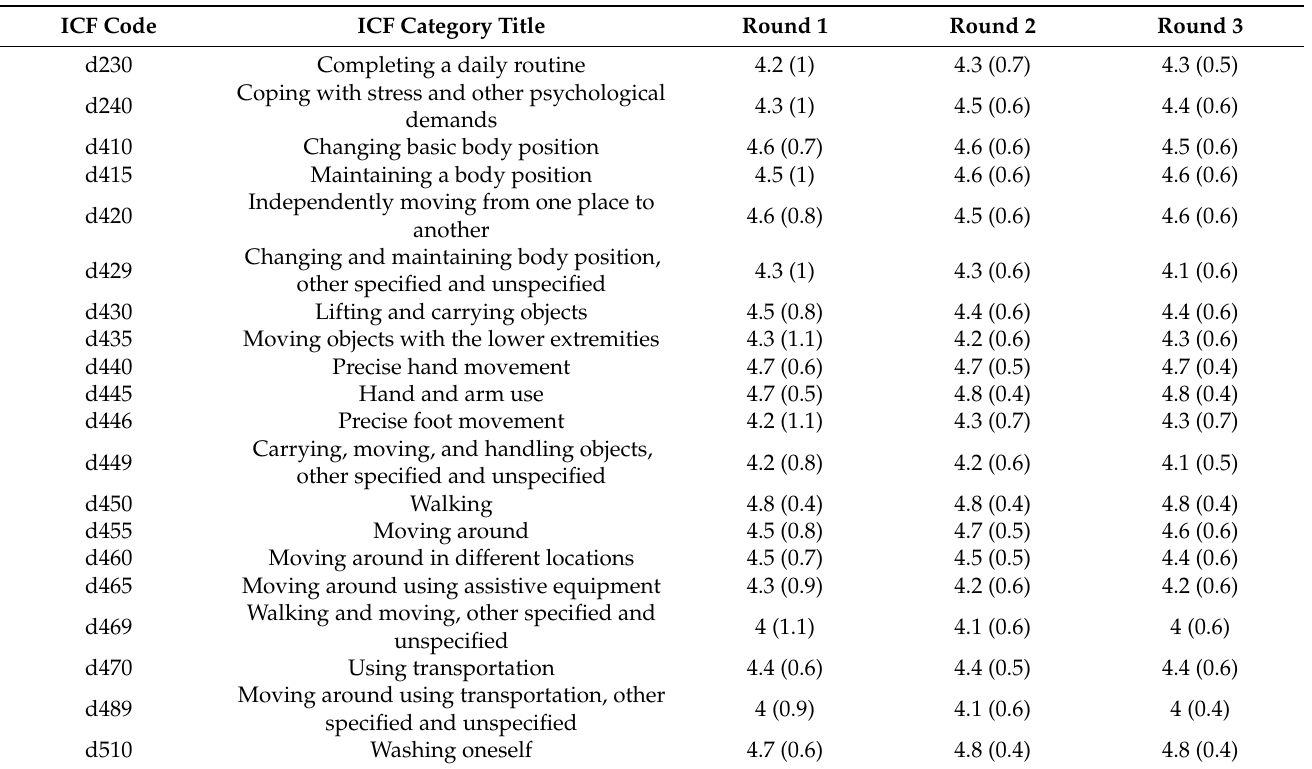
Table 2. International Classification of Functioning, Disability, and Health categories of the activities and participation component rated as important for the assessment of chronic burn injury over the three rounds of Delphi